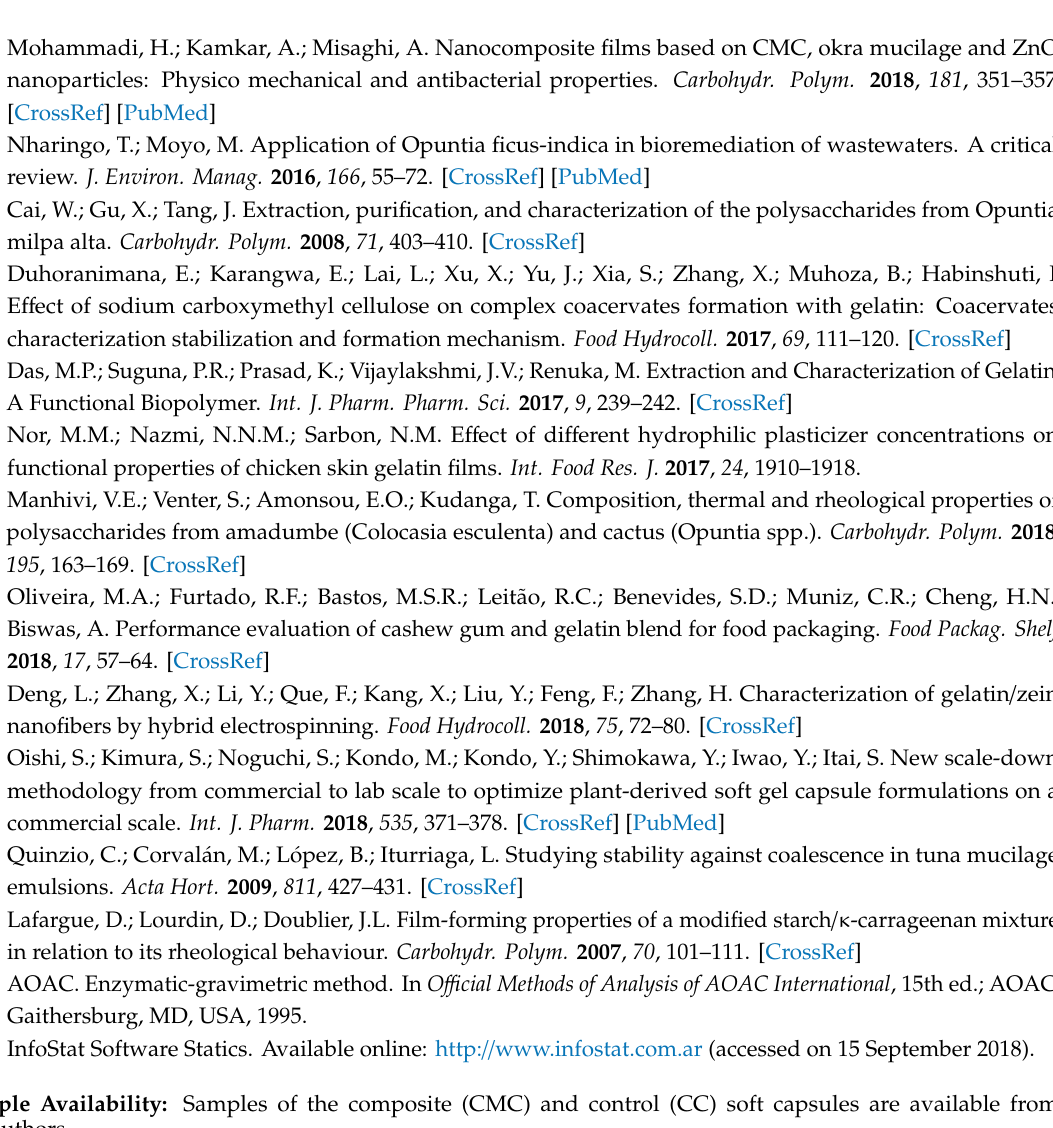
Sample Availability: Samples of the composite (CMC) and control (CC) soft capsules are available from the